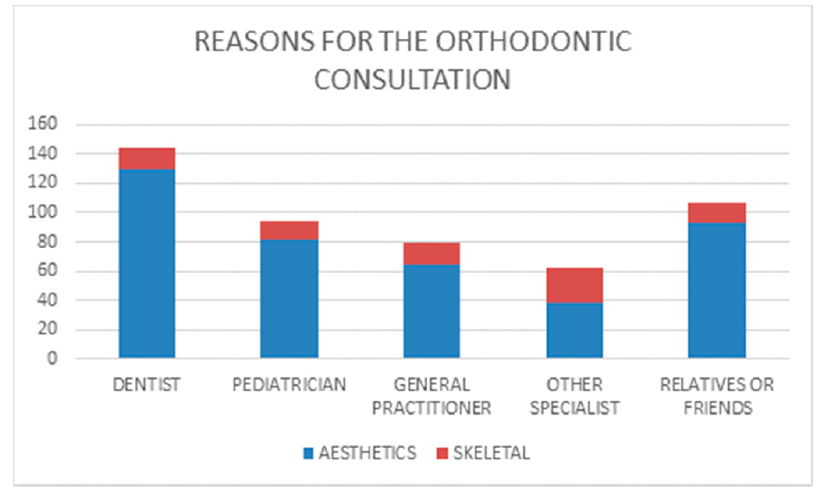
Figure 6. Reasons for the consultation.